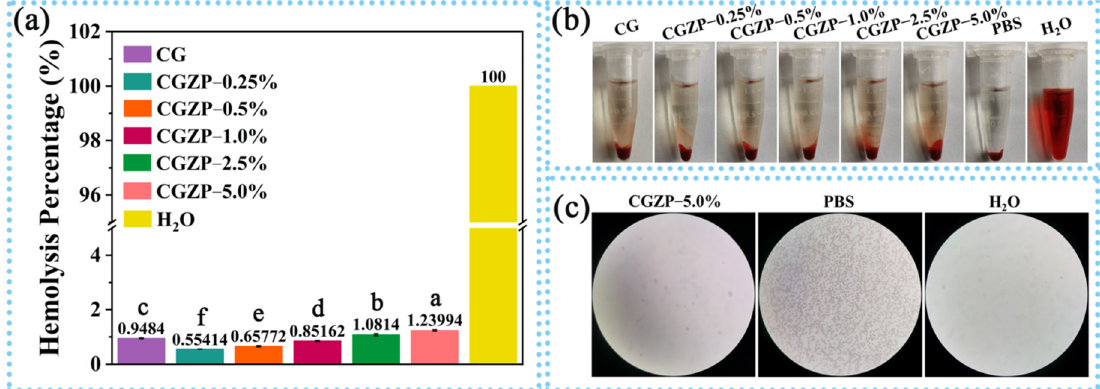
Figure 7. ( a ) Hemolysis Percentage of CG and CGZP films, and different letters in the columns indicate significant difference ( p < 0.05), ( b ) photographs of centrifuge tubes by disposing of RBCs with different films, PBS, and water, ( c ) microscope images of CGZP − 5.0% film and the controls treated with RBCs.